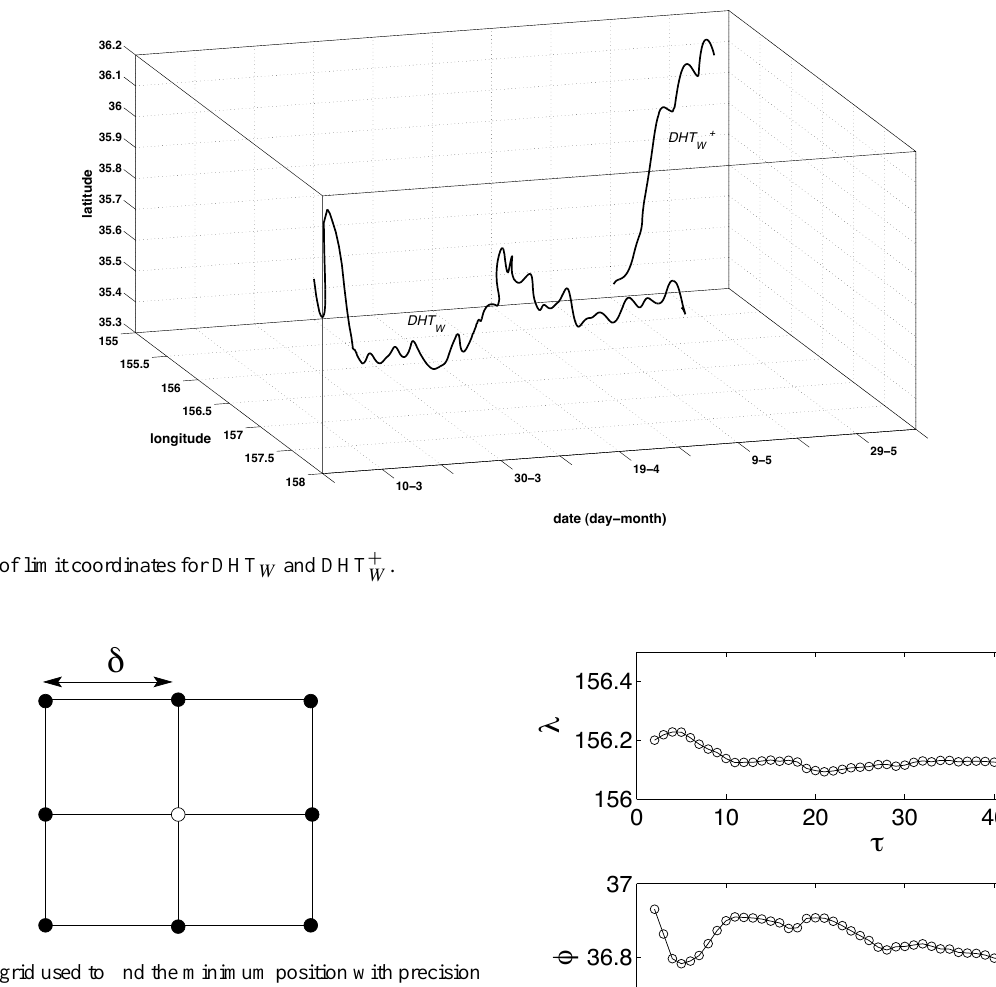
Fig. 13. The grid used to find the minimum position with precision δ . The white central dot indicates the position where the minimum is due.